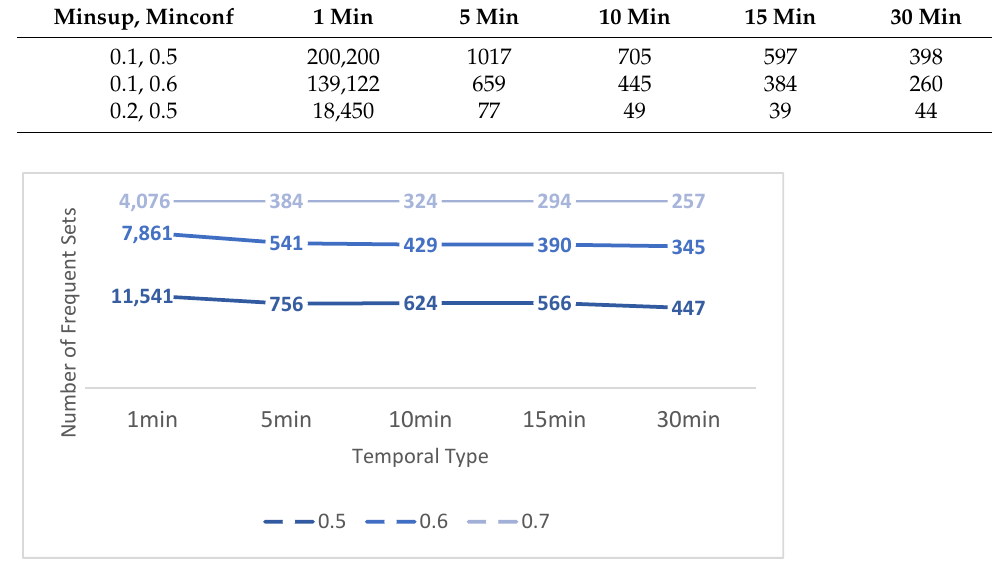
Figure 1. Number of frequent sets for different temporal types at different thresholds. Table 2. Number of association rules for each temporal type at different support and confidence levels.